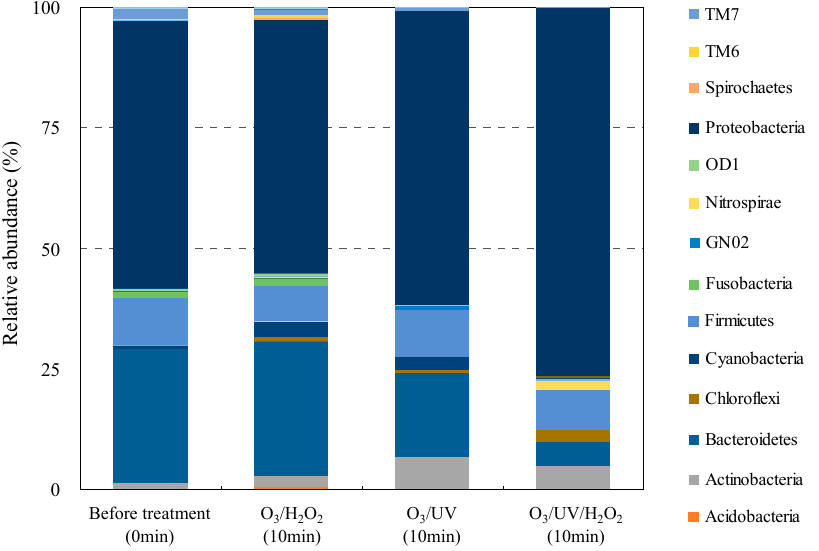
Figure 3. Taxonomic diversity of bacterial communities in O 3 -based AOP-treated wastewater samples. Interestingly, O 3 /UV and O 3 /UV/H 2 O 2 treatment changed the constitution of phyla in the STP effluent. The constitution was Proteobacteria (55%), Bacteroidetes (28%), Firmi- cutes (10%), TM7 (2%), and Fusobacteria (1%) before O 3 -based treatment; Proteobacteria (61%), Bacteroidetes (17%), Firmicutes (10%), Actinobacteria (7%), and Cyanobacteria (3%) after O 3 /UV treatment; and Proteobacteria (76%), Firmicutes (8%), Bacteroidetes (5%), Actinobacteria (5%), and Chlorobi (2%) after O 3 /UV/H 2 O 2 treatment. Meanwhile, the constitution of phyla was almost similar in O 3 /H 2 O 2 treatment: Proteobacteria